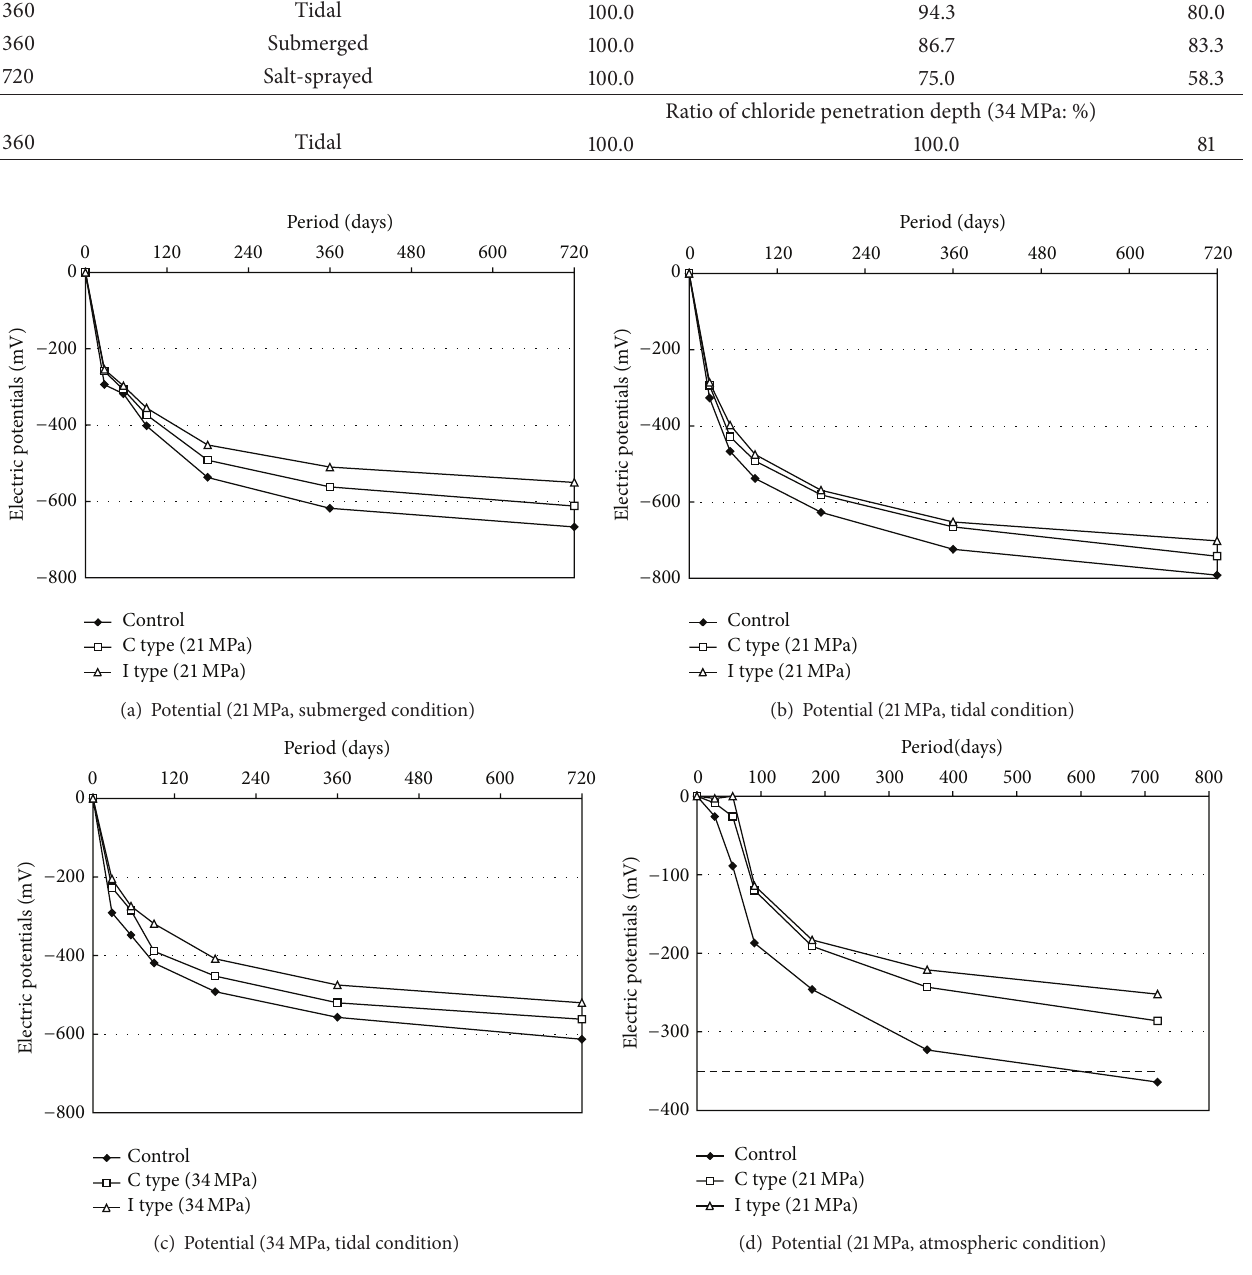
Figure 7: Result of measured potential in surface-impregnated